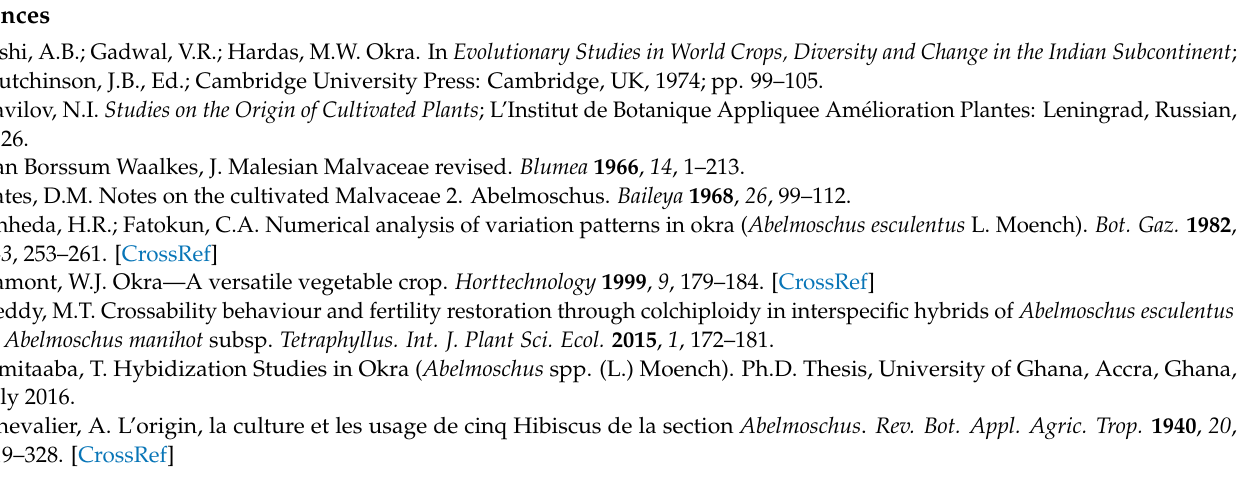
Table S2: Microsatellite markers used for diversity analysis and core collection establishment, Table S3: Morphological descriptor data of Abelmoschus